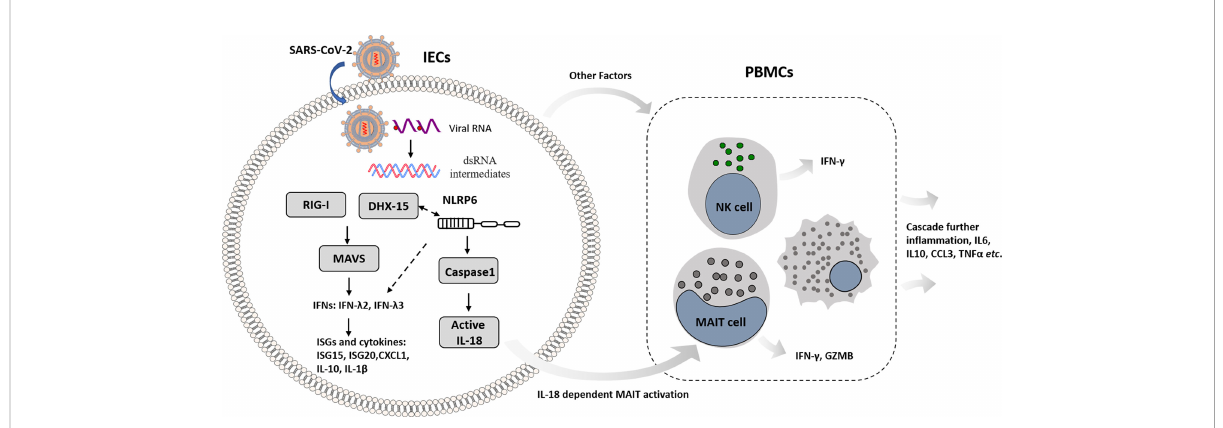
FIGURE 7 Schematic overview of mechanism basis of innate immunity in IECs response to SARS-CoV-2 infection and immune cross-talk with other immune cells in intestinal